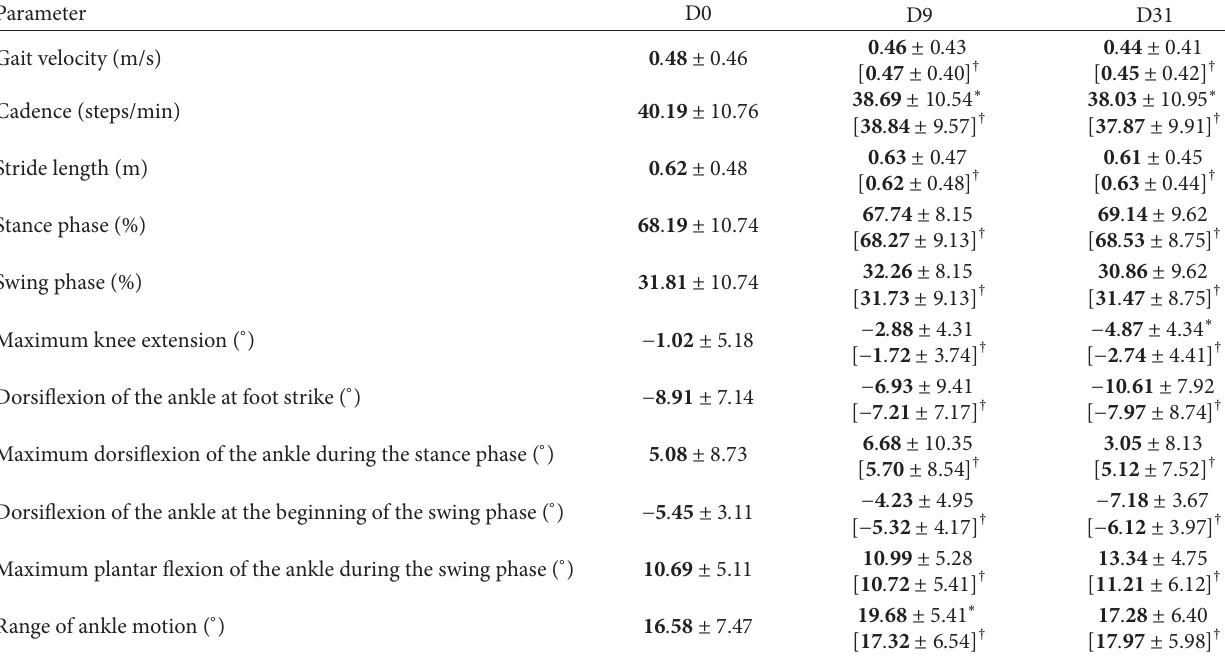
Table 2: Course of parameters recorded during quantitative analysis of walking (mean ± standard deviation) during the 1 Hz and 10 Hz ( † brackets) stimulation protocols: before (D 0 ) and after (D 9 : early assessment; D 31 : late assessment).